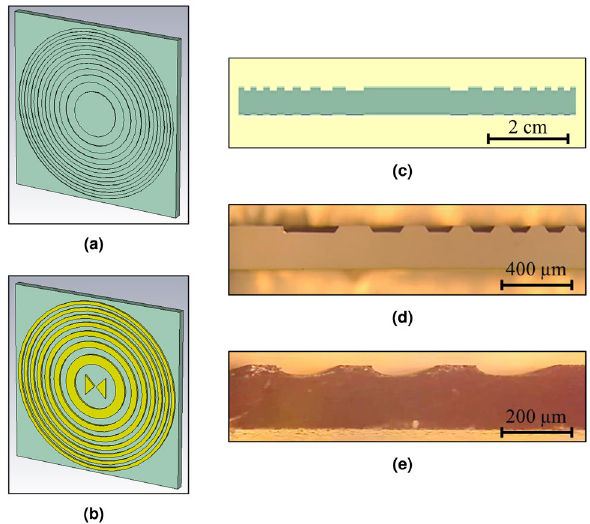
Figure 2. The layout structure and the transversal cut of the lens-antenna device ( a ) the top view. ( b ) The bottom view. ( c ) The transversal cut up the device, where the lens-antenna design was designed for 1 THz with 14 Fresnel zones, a focal plane at 15 mm, and a focal point resolution of 150 μm. ( d )Transversal cut of the device with anisotropic etching. ( e ) Transversal cut of the device with isotropic etching.